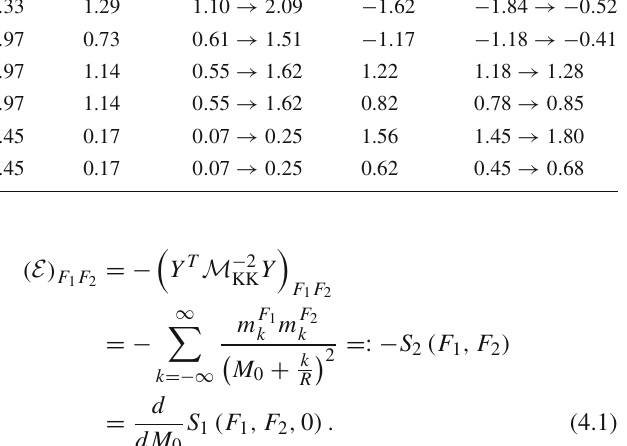
regions which reproduce the observed neutrino mixing for the different possible orderings of the mass eigenvalues. The first to cases correspond to the NO and the last two to the IO. The values are obtained by using the Best Fit values (BF) for the mixing angles and the 3 σ regions,